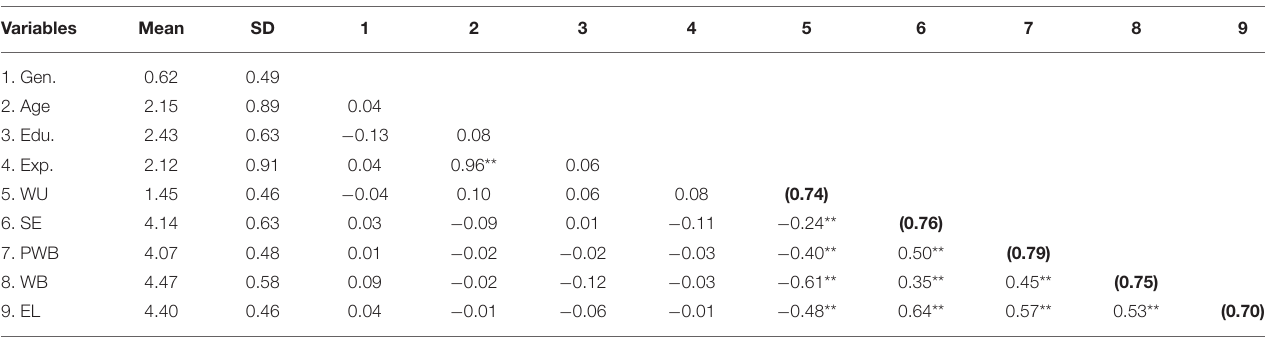
TABLE 1 | Descriptive statistics and correlations ( N = 218). Variables